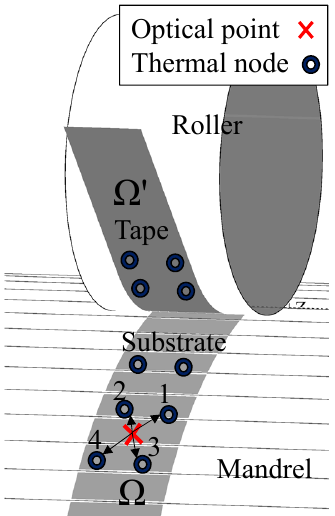
Figure 7. Distribution of the exemplary absorbed energy ( φ i ) inside the thermal domains ( Ω for the substrate, Ω (cid:48) for the tape).